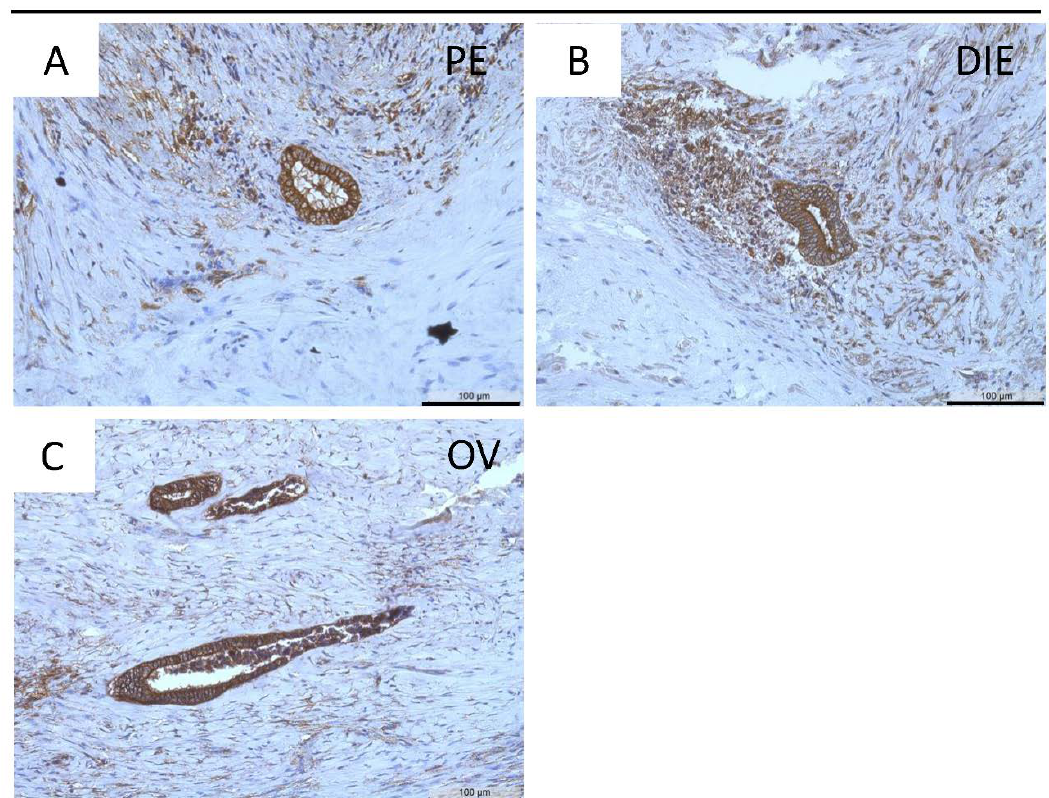
Figure 5. Immunohistochemical detection of MT3-MMP in peritoneal (PE, ( A )), deep infiltrating (DIE, ( B )), and ovarian endometriosis (OV, ( C )). Counterstaining was performed with hematoxylin. Magnification ( A – C ) 20×, scale bars 100 μm.